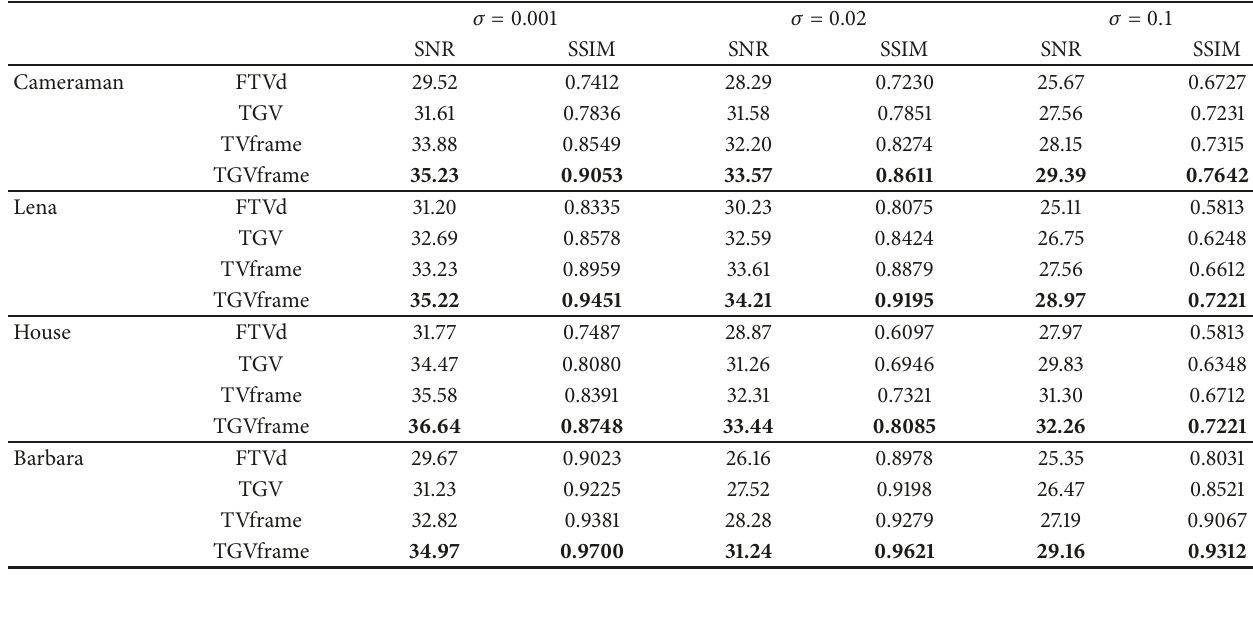
Table 4: Restoration results of different methods under motion blurring kernel with size 55 ∗ 135 with different noise levels.